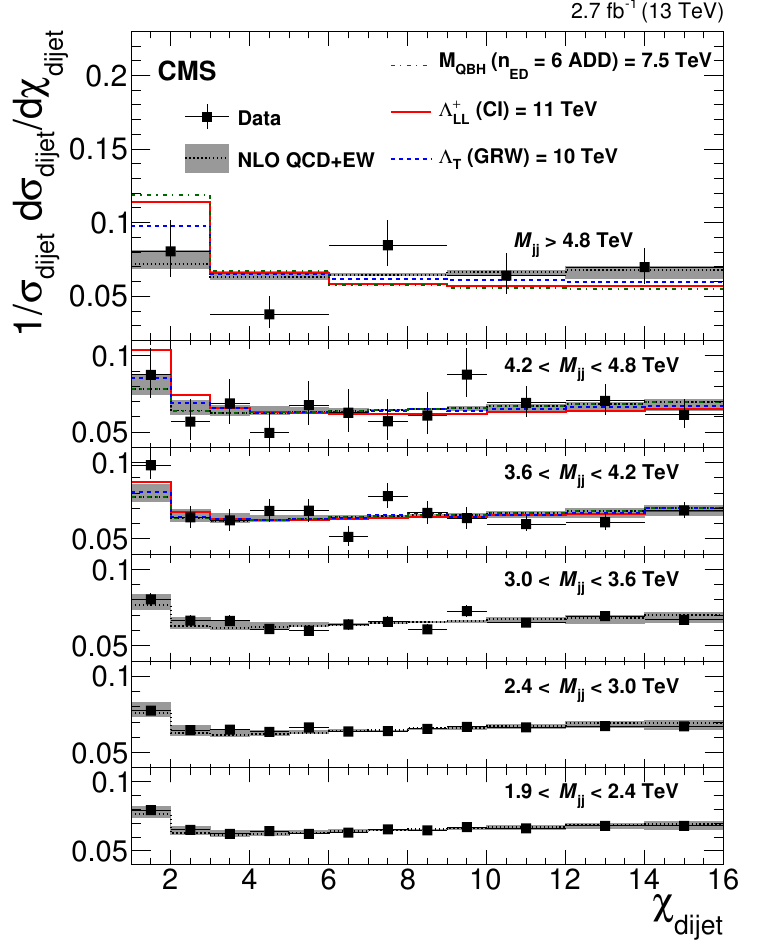
p Figure 1 . Normalized (cid:31) dijet distributions for 2 : 6 fb (cid:0) 1 of integrated luminosity at s = 13 TeV. The corrected distributions in data are compared to NLO predictions (black dotted line). The vertical bar on each data point represents statistical and systematic experimental uncertainties combined in quadrature. The horizontal bar indicates the bin width. Theoretical uncertainties are indicated by the gray bands. Also shown are the predictions for QCD+QBH with n ED = 6 and M QBH = 7 : 5 TeV (green dashed-dotted line), QCD+CI with (cid:3) + = 11 TeV (red solid line), and QCD+ADD with LL (cid:3) T (GRW) = 10 TeV (blue dashed